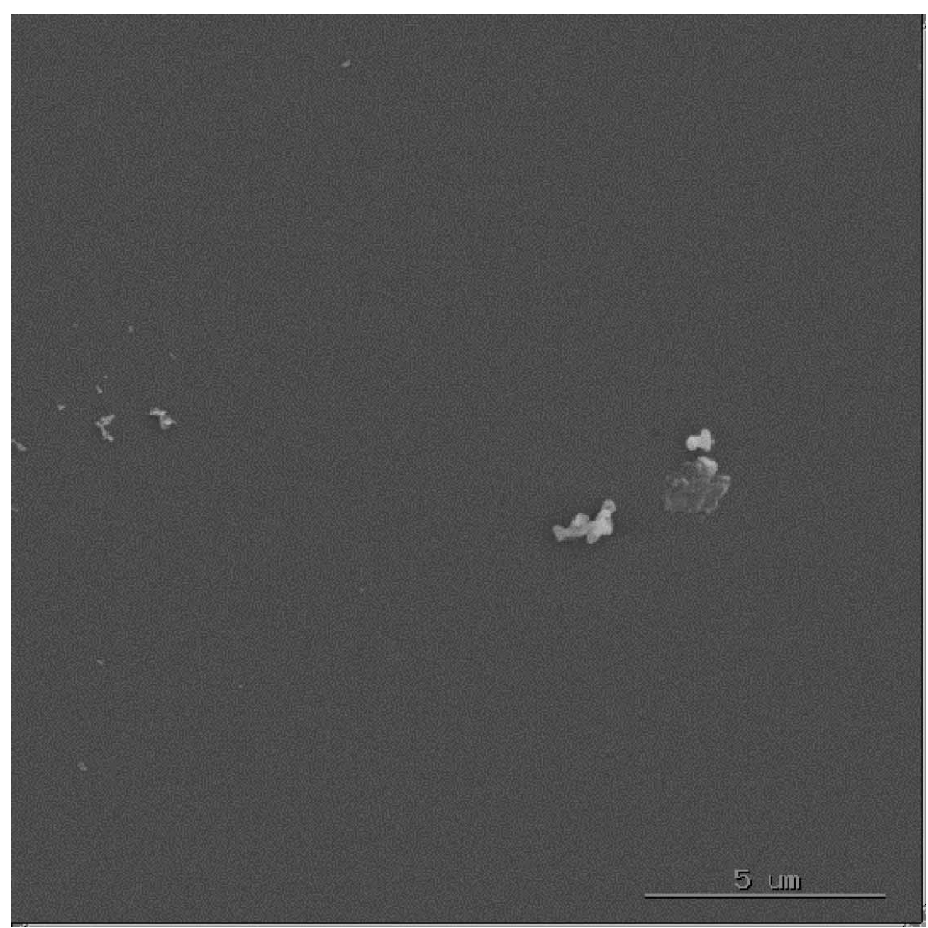
FIGURE 8 SEM for quenched sample of n -Si from 400 (cid:1) C with scale of 5 m